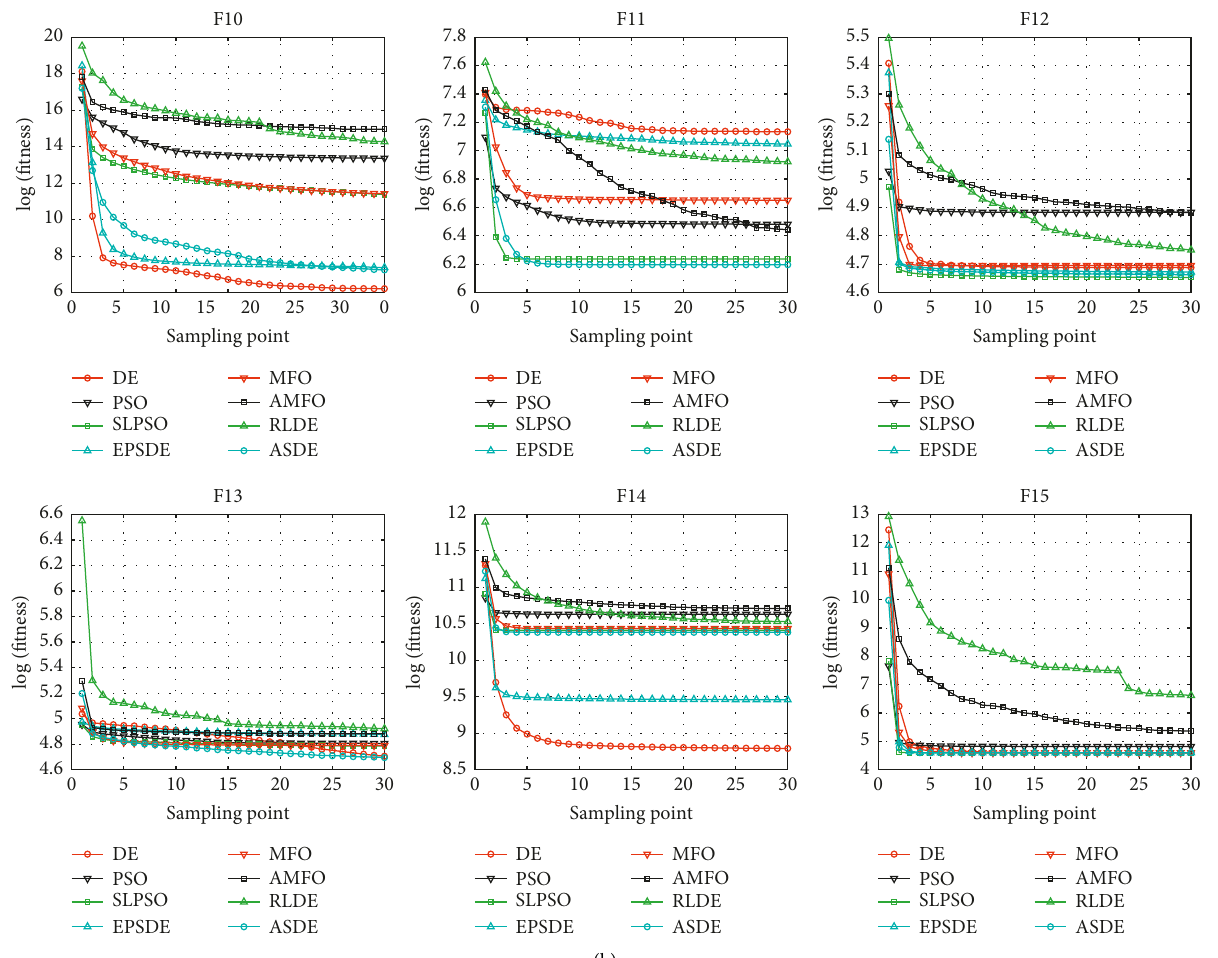
Figure 4: Convergence performance of the eight compared algorithms on 25 functions of